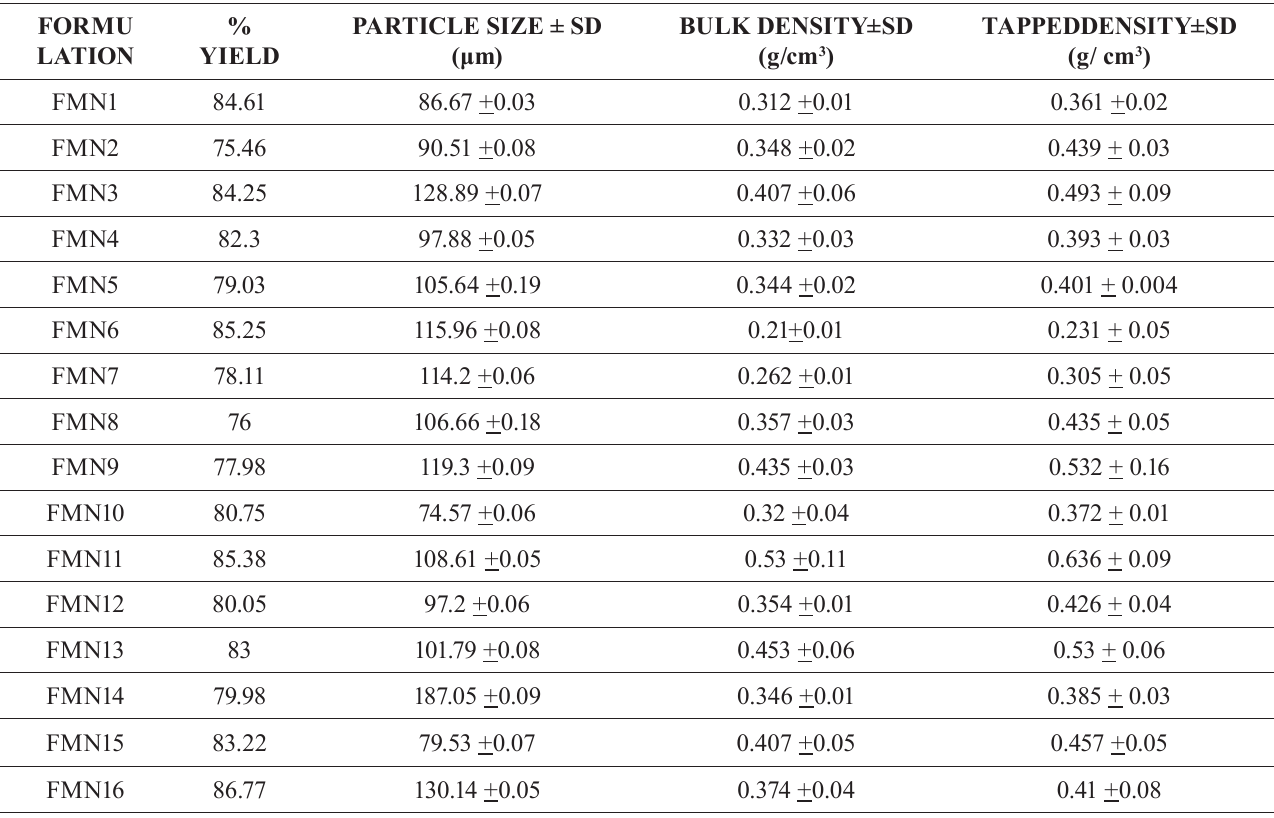
TABLE II - Results of % yield, particle size, bulk density and tapped density FORMU